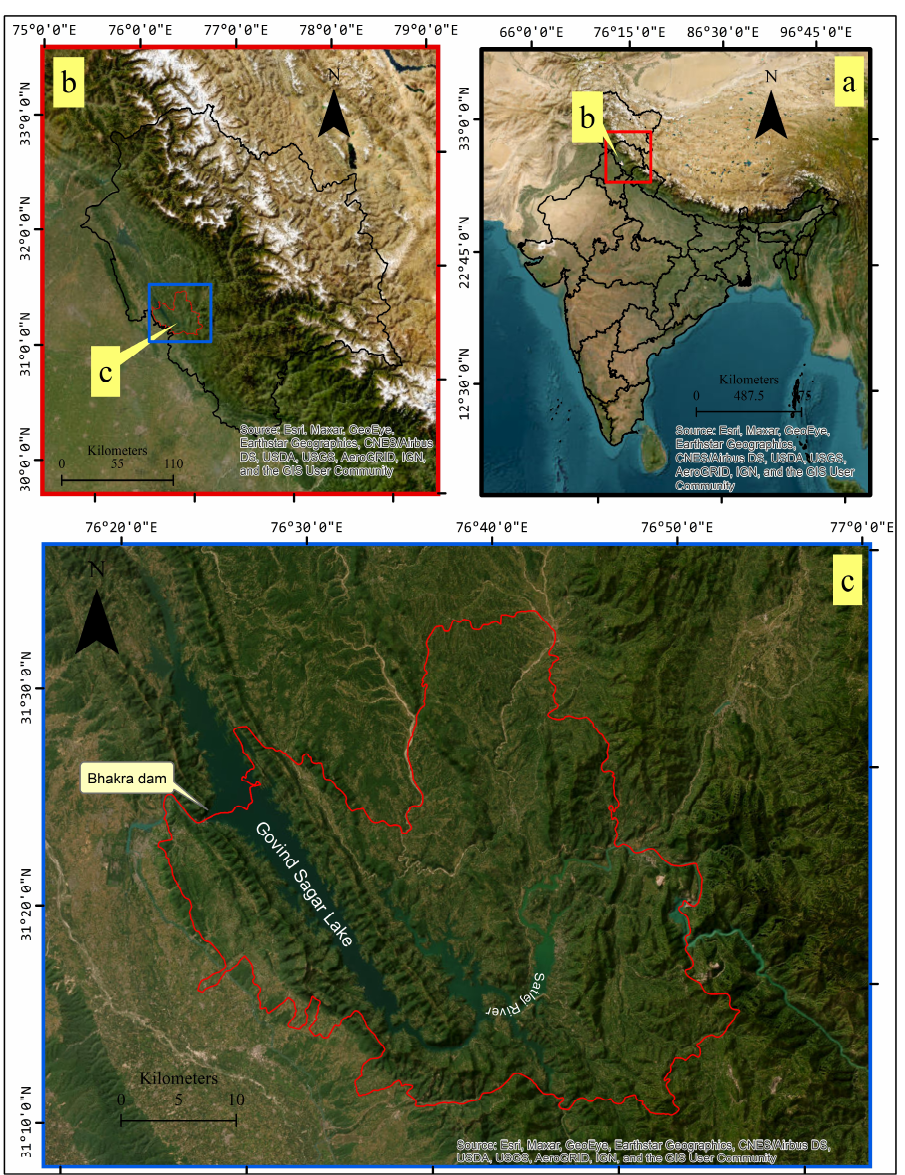
Figure 1. Location of the study area. ( a ) India, ( b ) Himachal Pradesh, and ( c ) Bilaspur District. Map coordinates are in UTM Zone